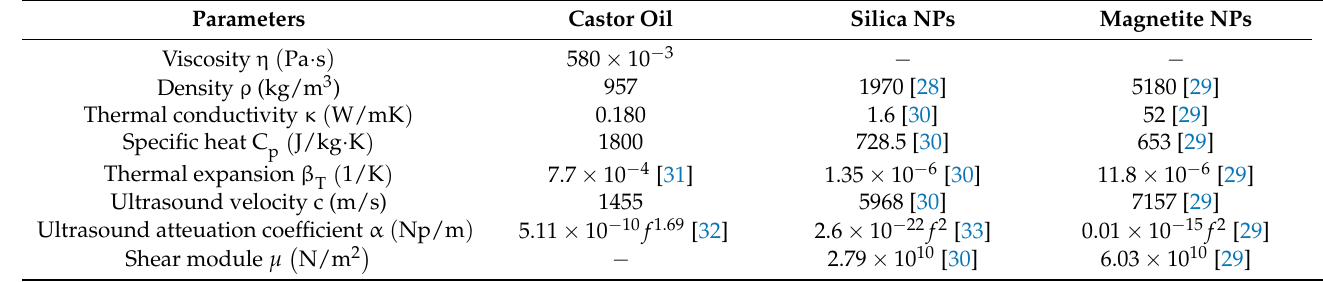
Table 1. The physical parameters of the pure castor oil (continuous phase) and magnetic and non- magnetic particles (dispersed phase) for 25 ◦ C. If the references are not given, the values come from either the measurements or data sheets. For the attenuation coefficient, the frequency, f , is expressed in Hz